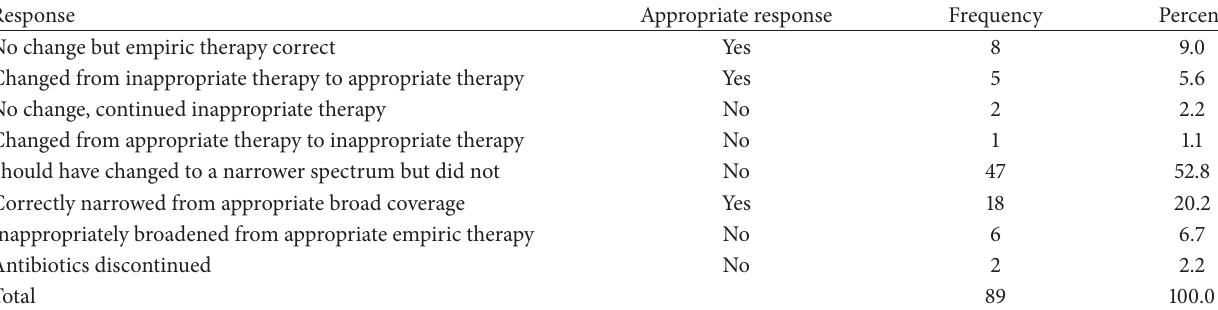
Table 4: Physician response to direct susceptibility